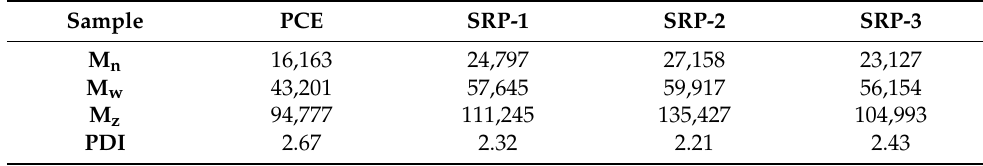
Table 5. Molecular properties of the synthesized